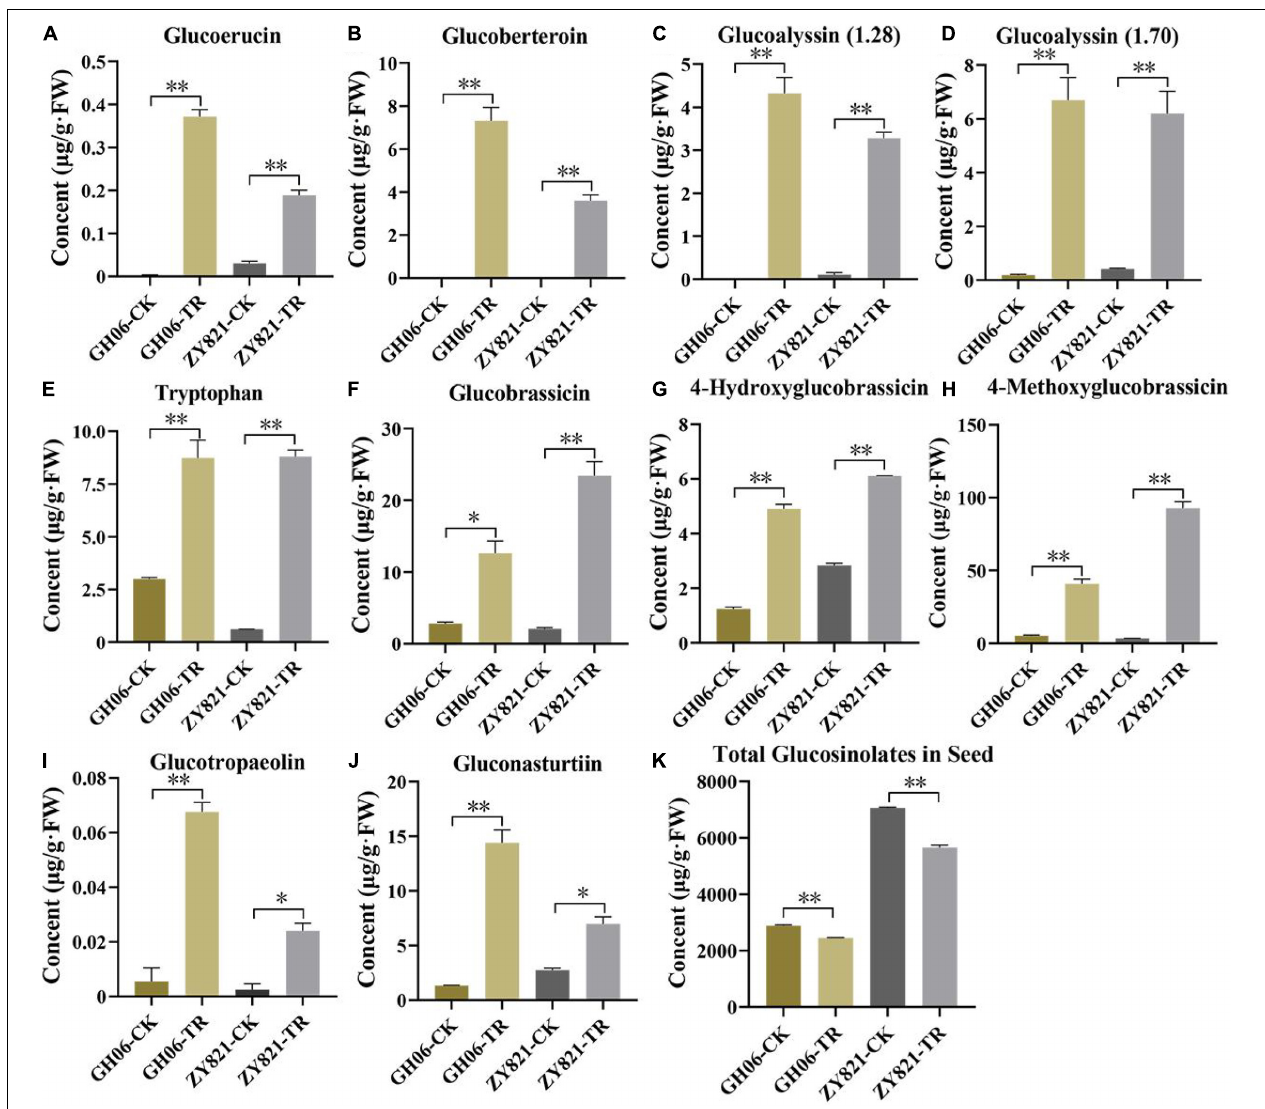
FIGURE 4 | The GSLs profiles with significant differences in rapeseed siliques. (A–J) The contents of 10 GSLs in siliques of GH06 and ZY821 at 35DAP. (K) Total contents of GSLs in seeds of GH06 and ZY821 at 35DAP. Error bars represent the means ± SD, and the asterisks represent significant differences from the CK, with ∗ p < 0.05 or ∗∗ p < 0.01. CK, the control; TR, shading